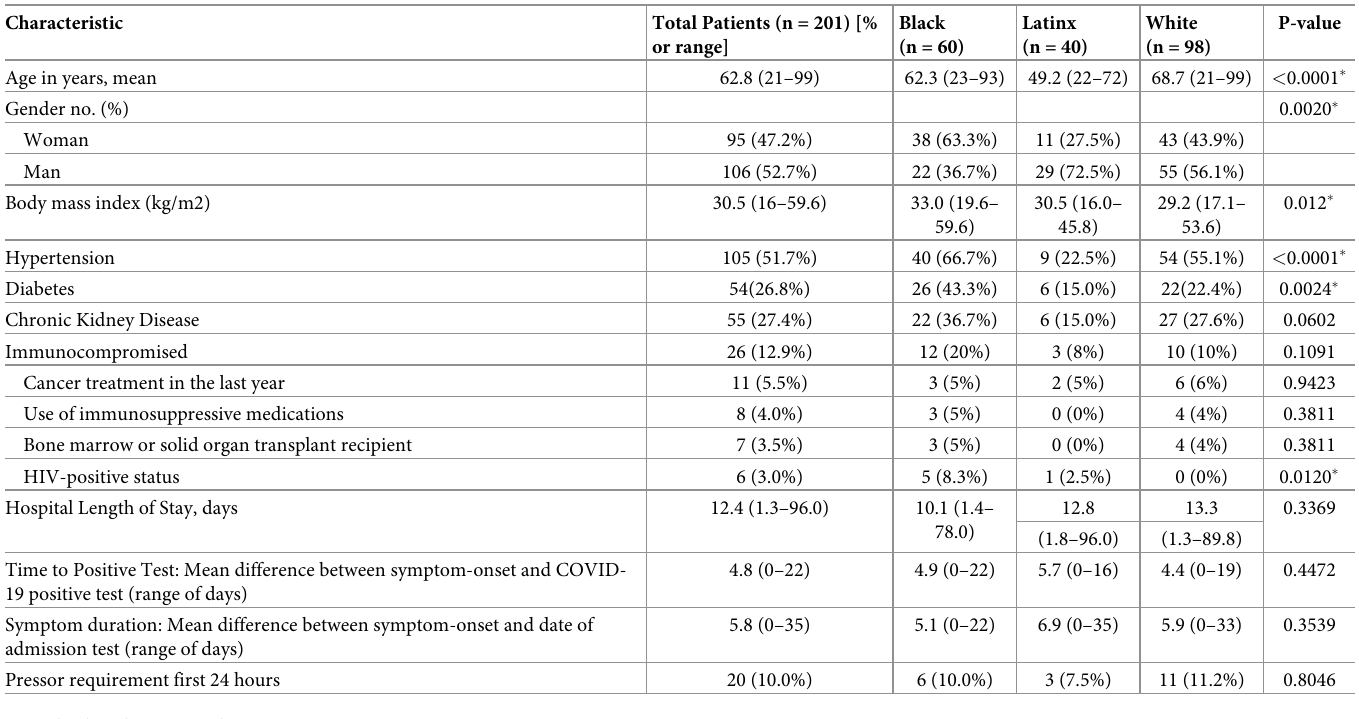
Table 1. Demographics and clinical characteristics of the study cohort.